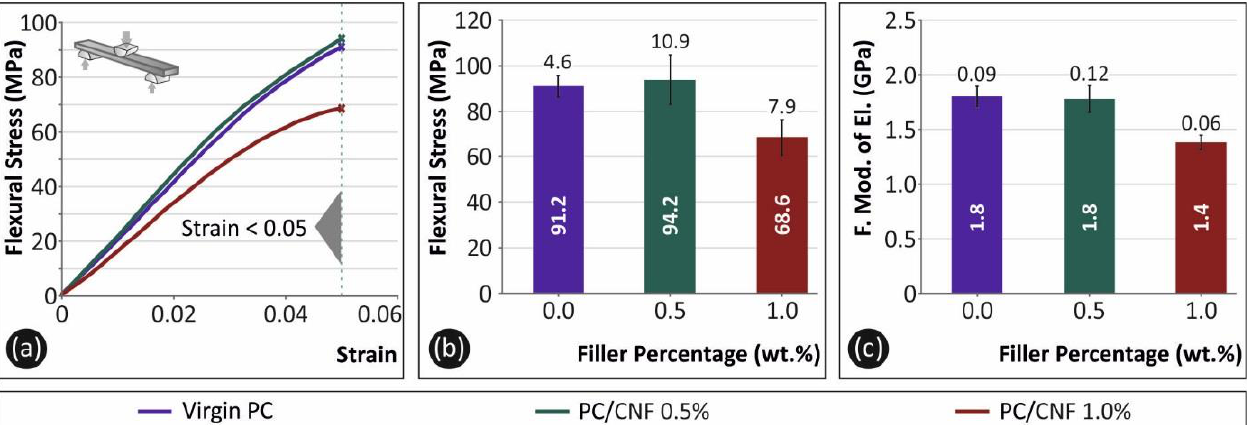
Figure 4. Flexural test results: ( a ) A representative stress (MPa) to strain (mm/mm) curve for each tested material, ( b ) Average flexural strength (MPa) to filler concentration in the nanocomposites, ( c ) Average flexural modulus of elasticity (MPa) to filler’s loading percentage.